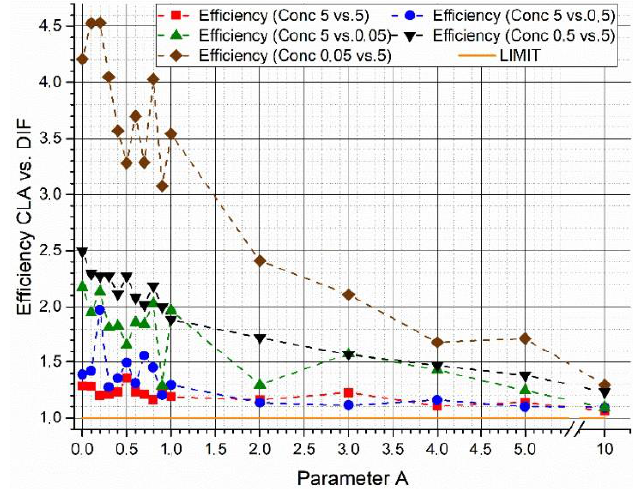
Figure 5. Influence of concentration differences on the efficiency gain (P) between the two algorithms. The plot describes the parametric study on concentration variations and its effect on the accuracy of the W DIF -LSM algorithm as a function of the parameter A variation, using for every test the same couple of synthetic spectra.